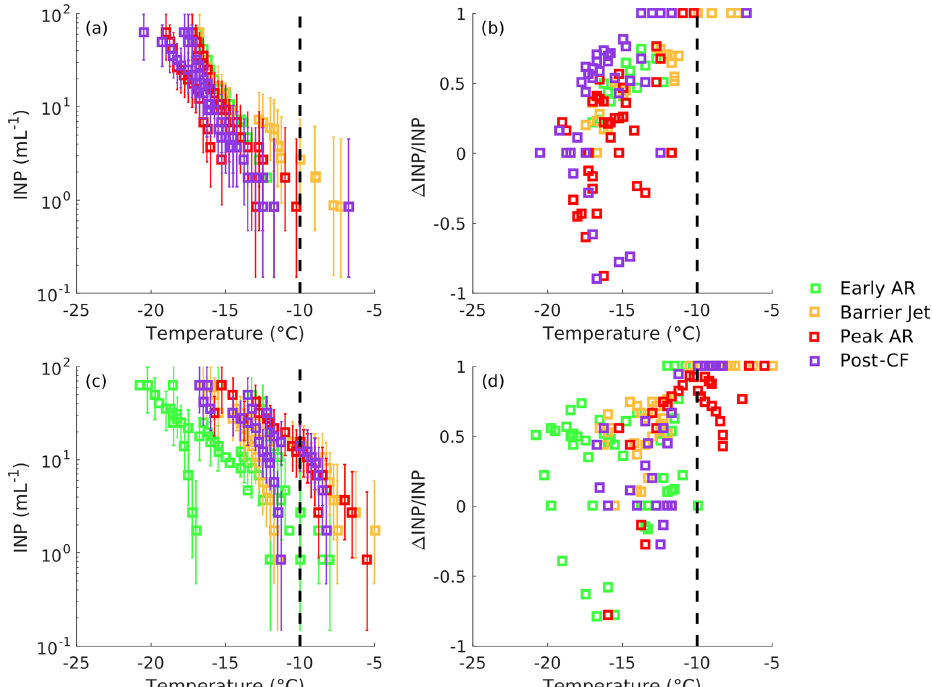
Figure 5. (a) Unheated INP (T ) (mL − 1 ) from BBY precipitation during Early AR (green), Barrier Jet (yellow), Peak AR (red), and Post-CF (purple) periods. Whiskers denote technique standard error (mL − 1 ). (b) As in a, except for (cid:49) INP (T )/ INP (T ) . (c) As in (a) , except for unheated precipitation samples from CZC. (d) As in (c) , except for (cid:49) INP (T )/ INP (T )